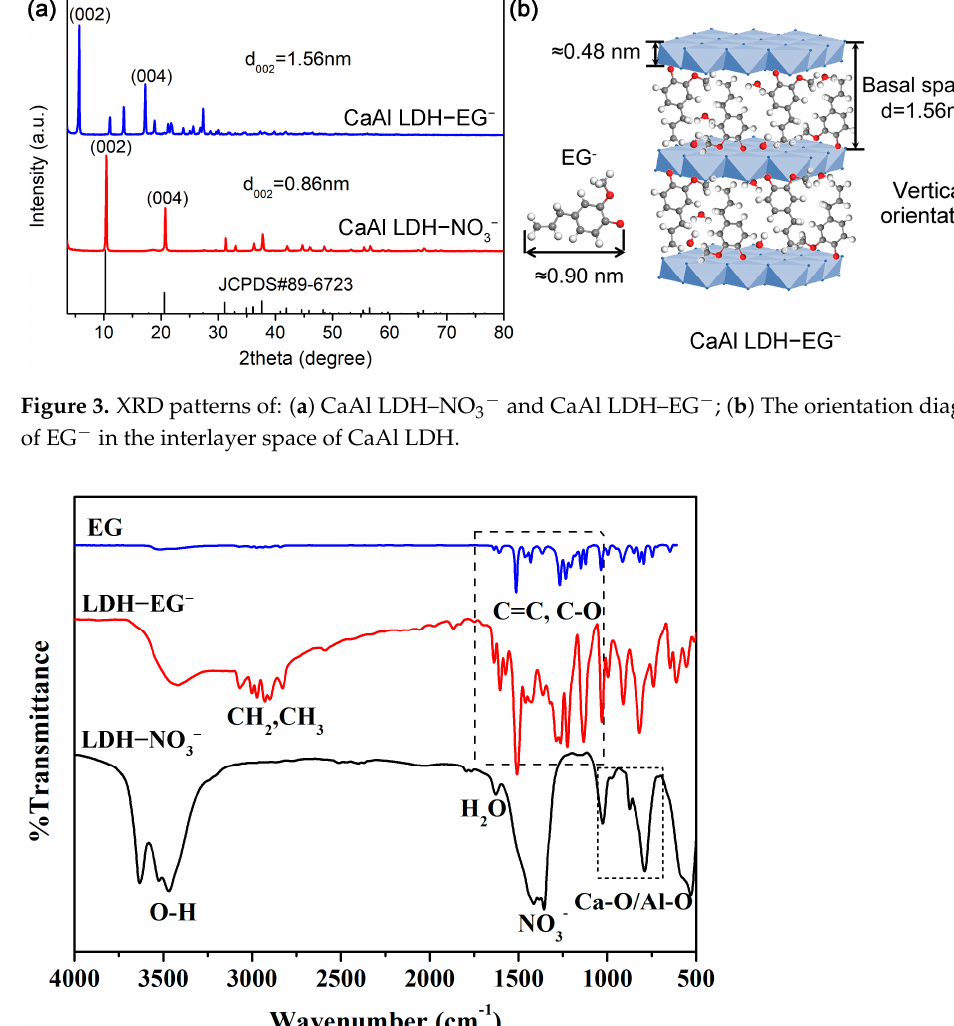
Figure 4. FTIR spectra of EG and prepared CaAl LDHs.